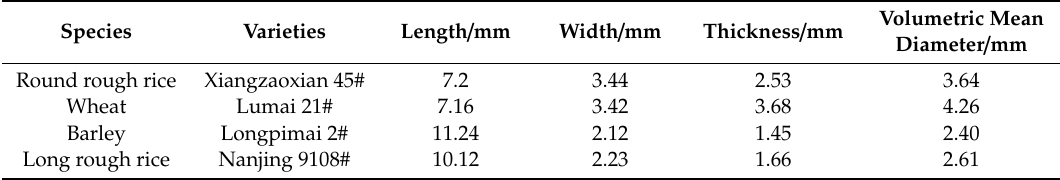
Table 1. Geometric parameters of four kinds of